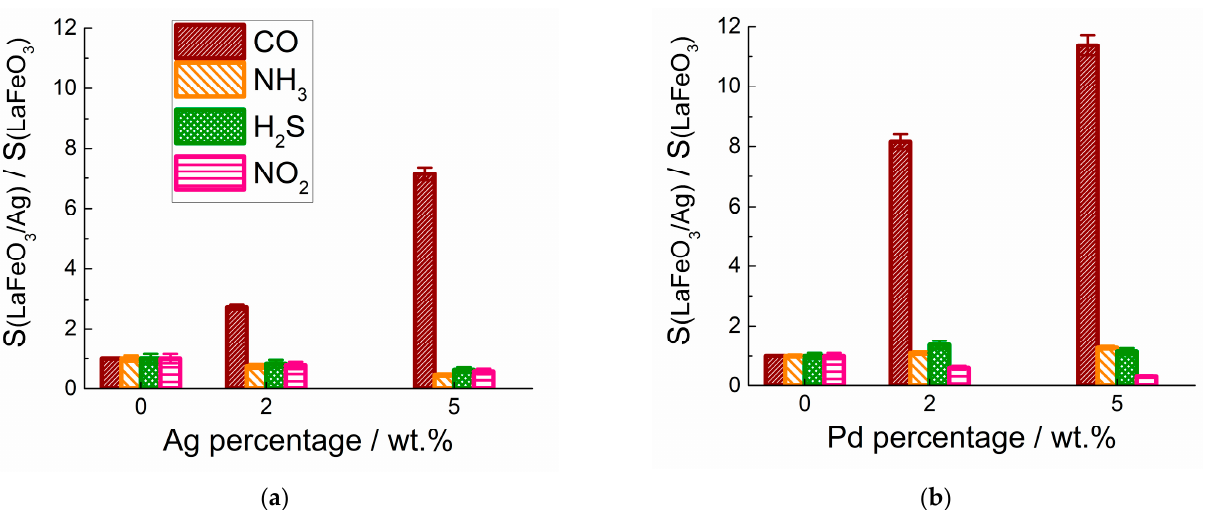
Figure 8. Ratio of maximum sensor signals of LaFeO 3 /Ag ( a ) and LaFeO 3 /Pd ( b ) to sensor signals of pristine LaFeO 3 to CO (20 ppm), NH 3 (20 ppm), H 2 S (2 ppm) and NO 2 (1 ppm) at appropriate operating temperatures.